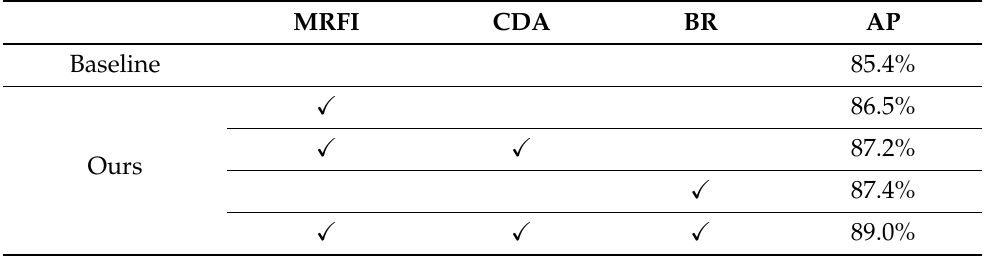
Table 1. Quantitative evaluation of the proposed